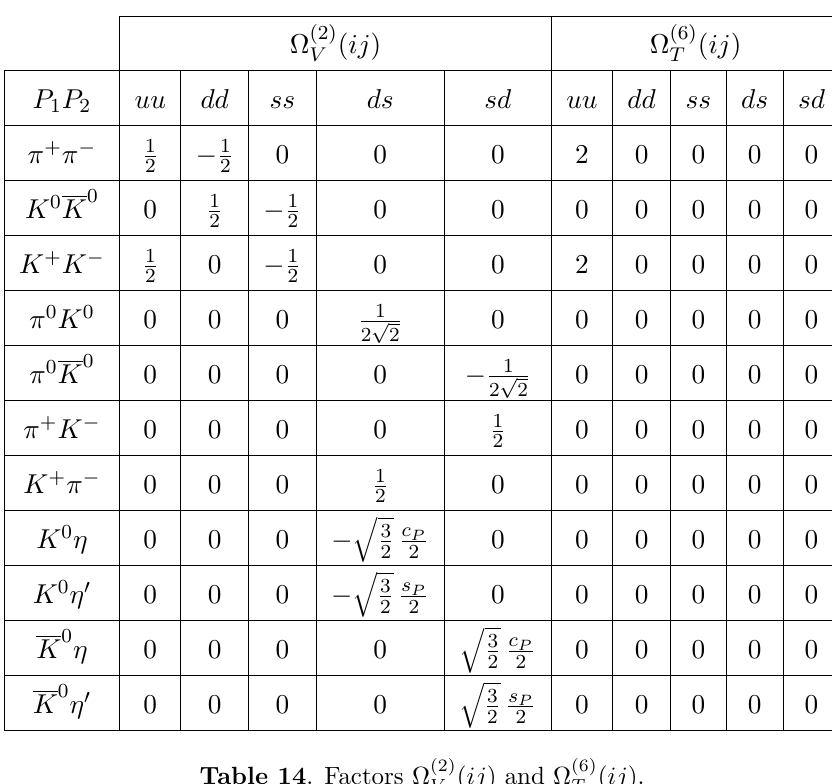
Table 14 . Factors Ω (2)